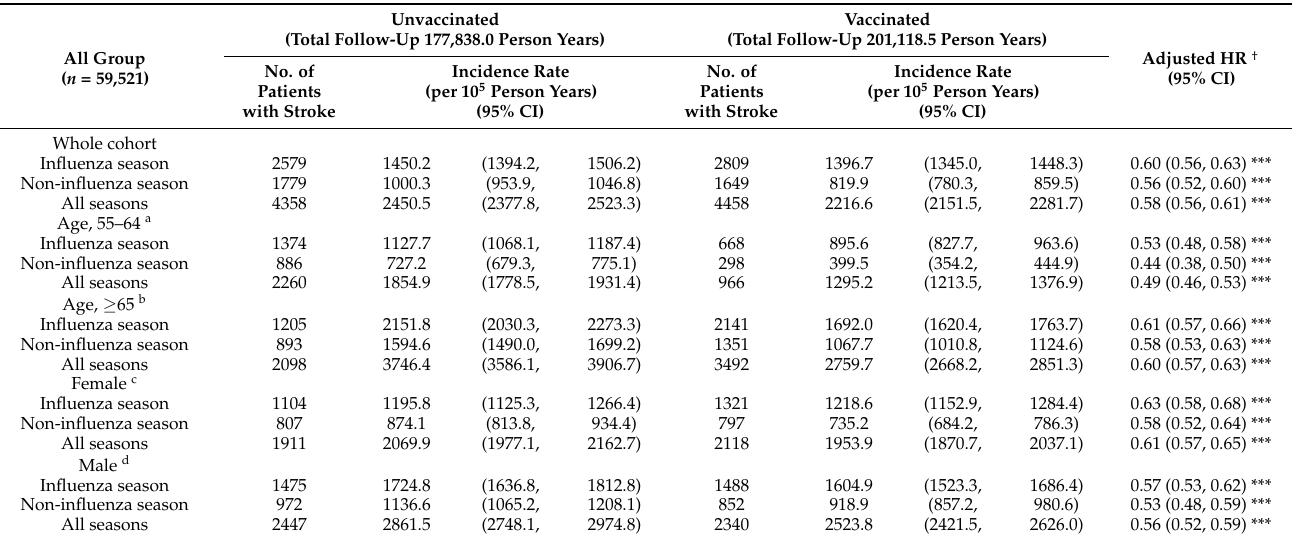
Table 2. Risk of All Strokes among the Unvaccinated and Vaccinated in the Study